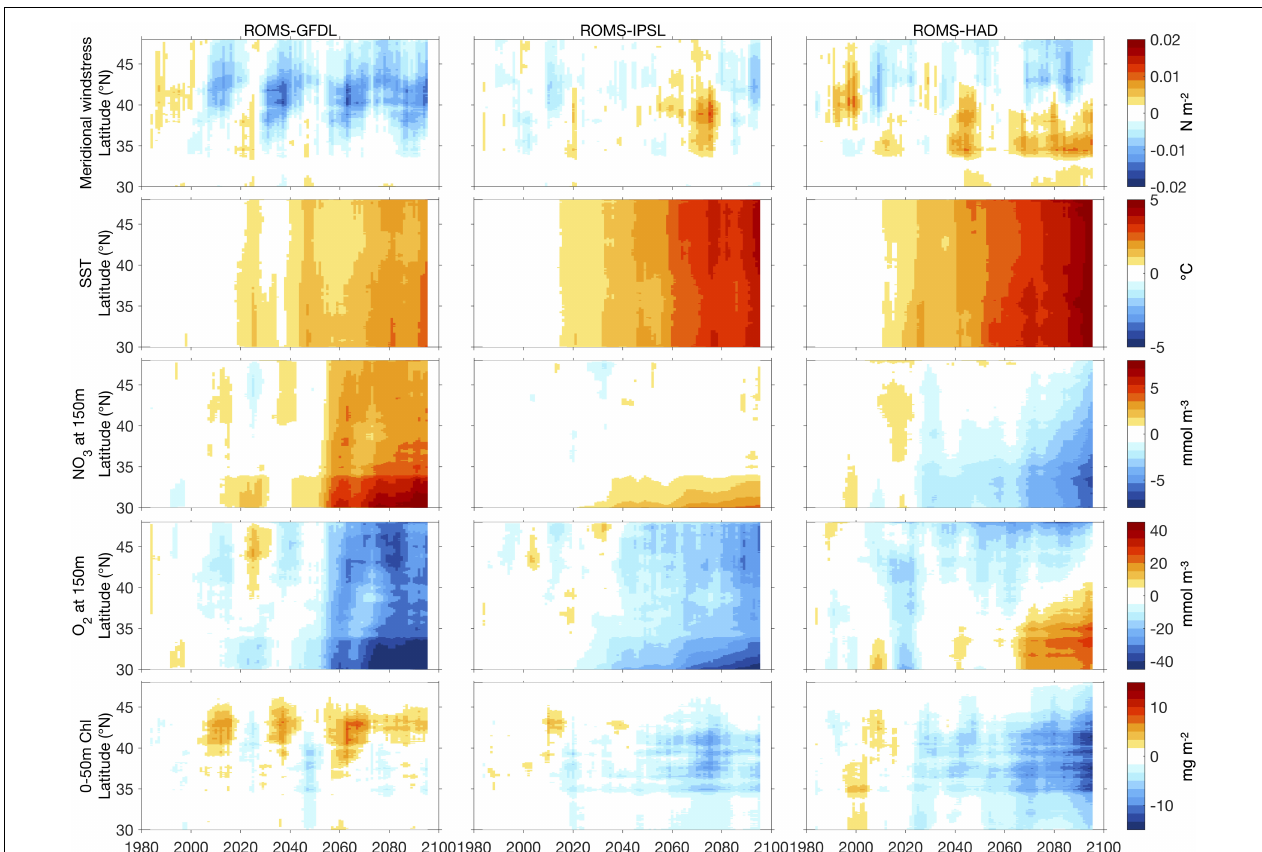
FIGURE 8 | Hovmöller diagrams of 10-year running mean annual anomalies averaged from the coast to 100 km offshore of meridional wind stress (top row), SST (second row), nitrate (third row) and dissolved oxygen (fourth row) at 150 and 0–50 m integrated chlorophyll (bottom row) with respect to the historical period (1980–2010), from the high-resolution downscaled projections: ROMS-GFDL (left) , ROMS-IPSL (center) , and ROMS-HAD (right)